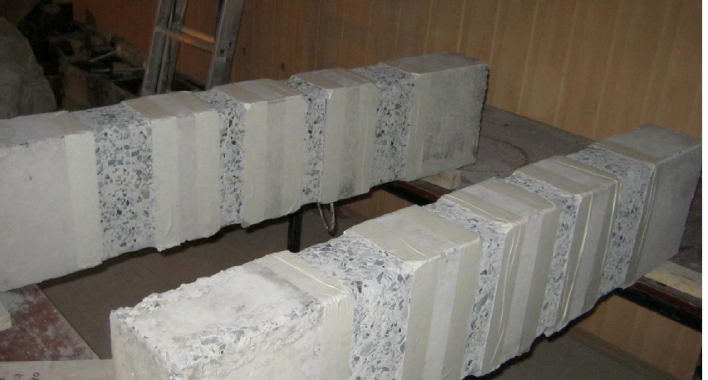
Figure 2. General view of the columns, prepared for reinforcement with stirrups and installation of end stirrups-anchors.